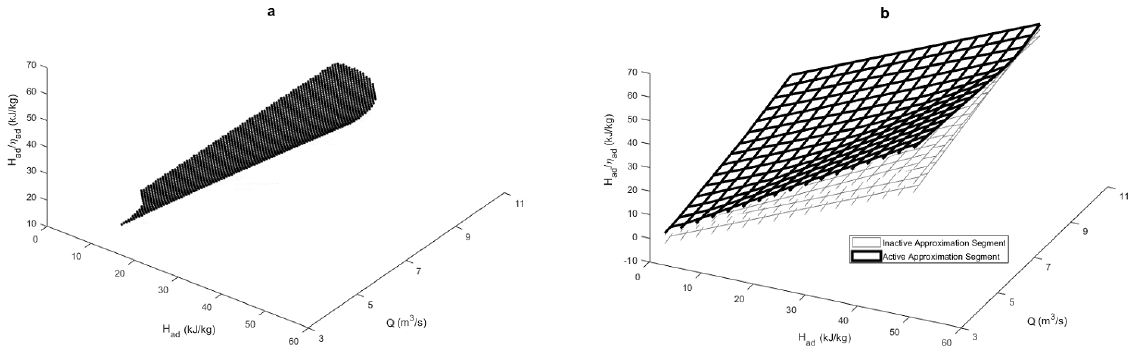
Figure 13. ( a ) Rigorous relationship of H ad ( b ) Approximation of rigorous relationship of H ad